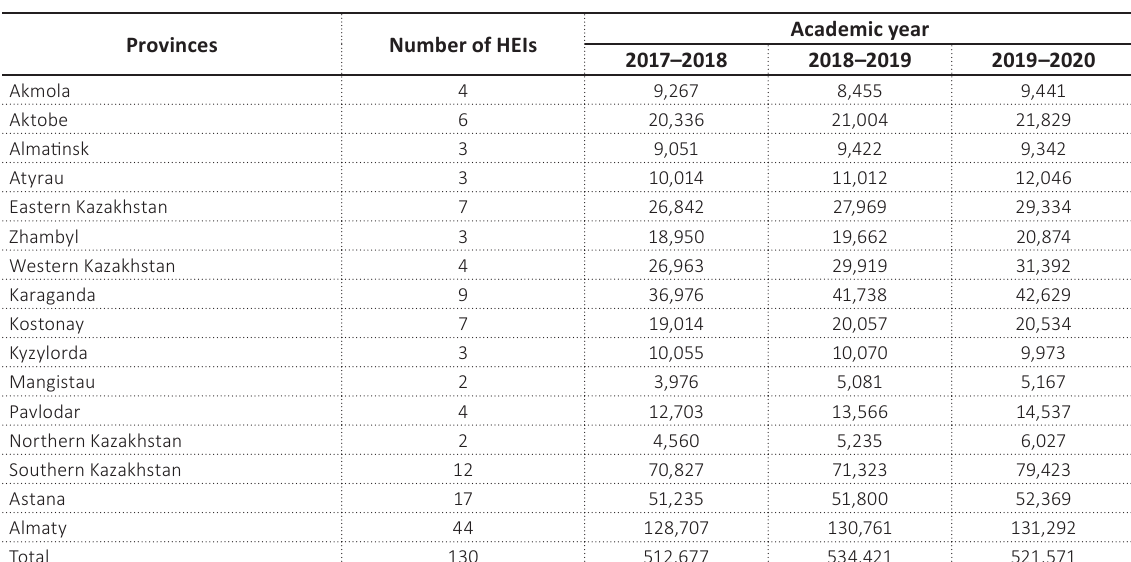
Table 2. Regional dynamics of